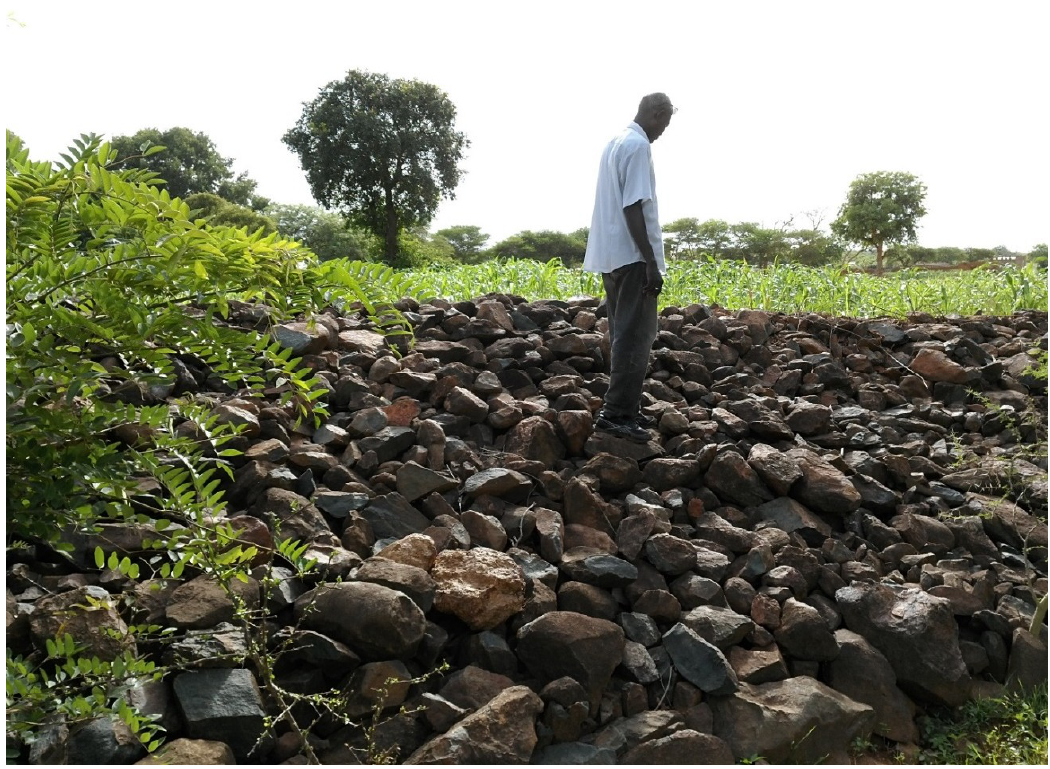
Figure 2. Level permeable dam, Commune of Kongoussi, July 2017 – Photo by Colin Thor West.